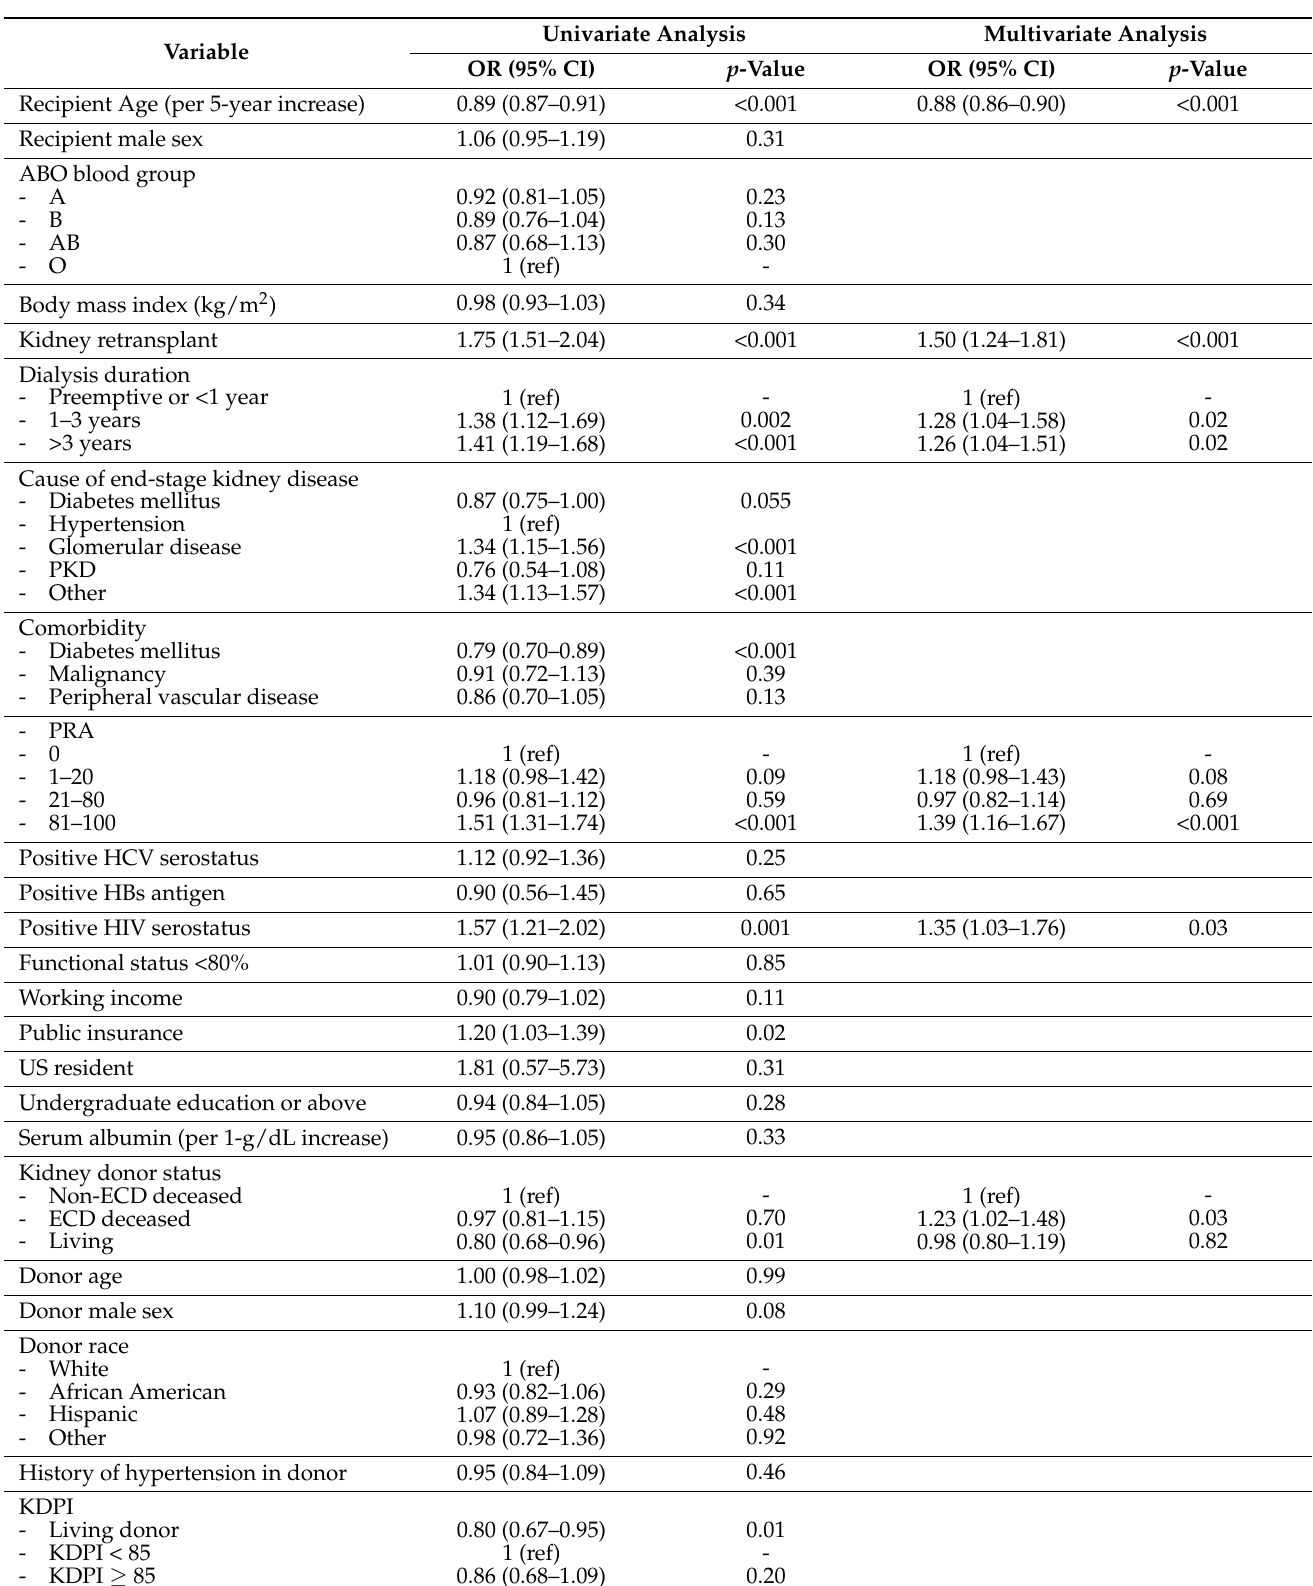
Table 2. Univariable and multivariable logistic regression analysis for acute